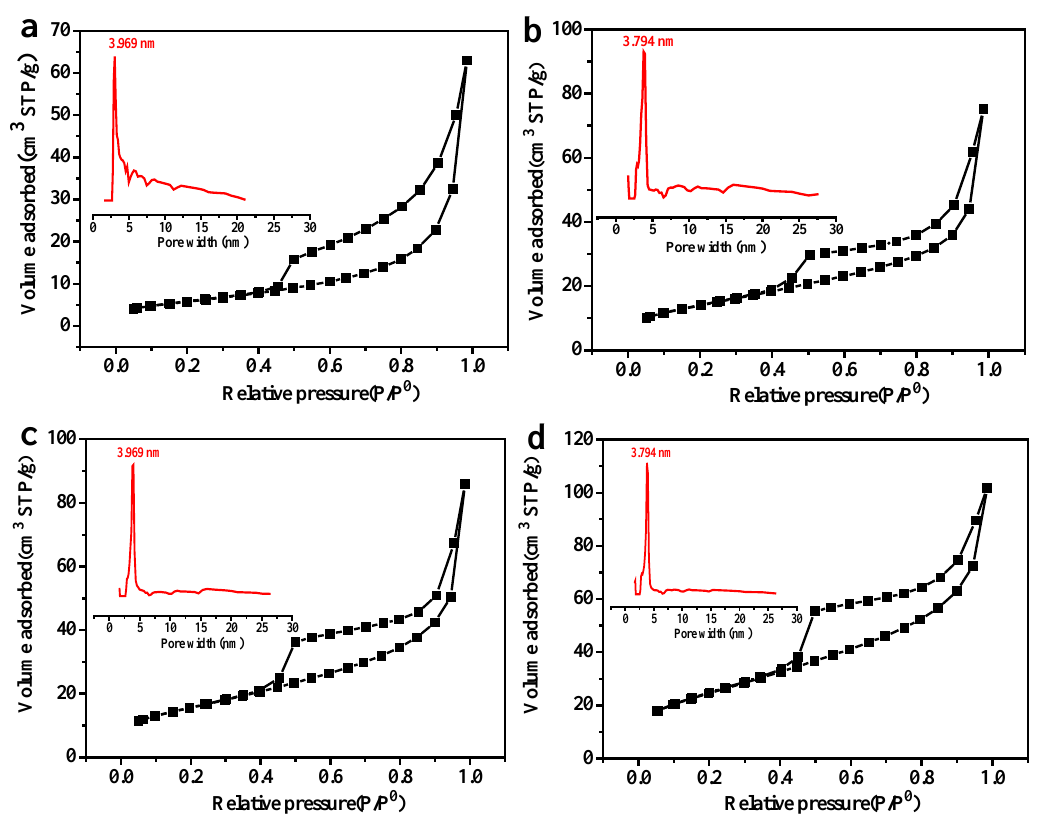
Figure 9. Nitrogen adsorption–desorption curve (in black) and mesoporous pore size distribution (in red) of the PSCMs based on the hot–dry casting process at ( a ) 40 ° C, ( b ) 60 ° C, ( c ) 80 ° C, and ( d ) 100 ° C.